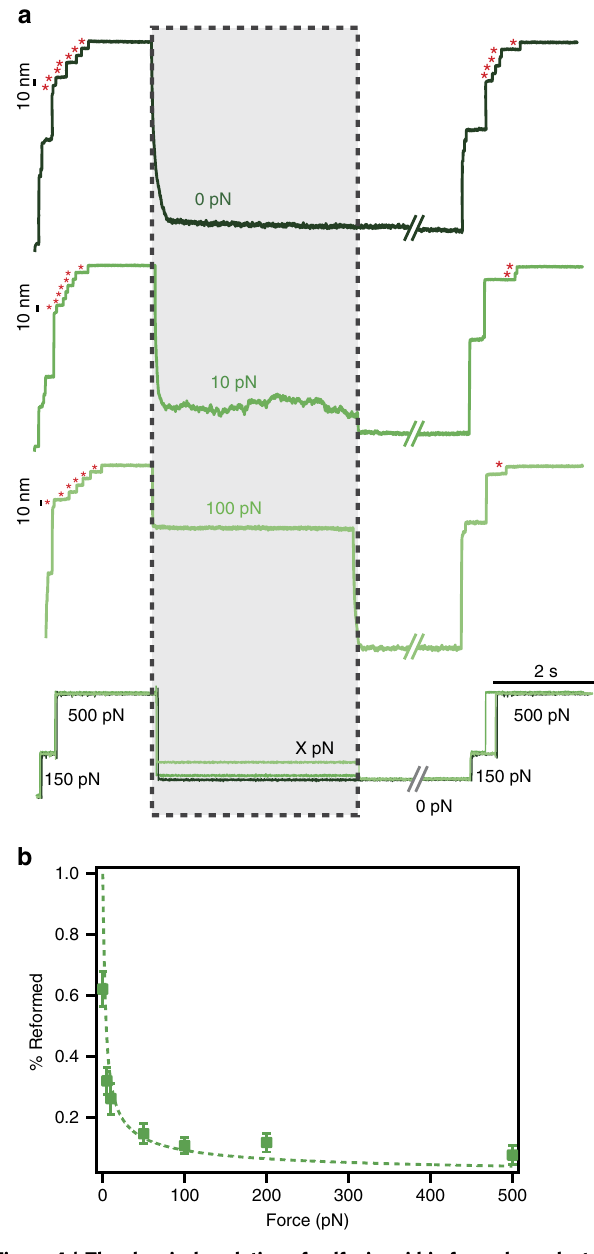
Figure 4 | The chemical evolution of sulfenic acid is force-dependent.